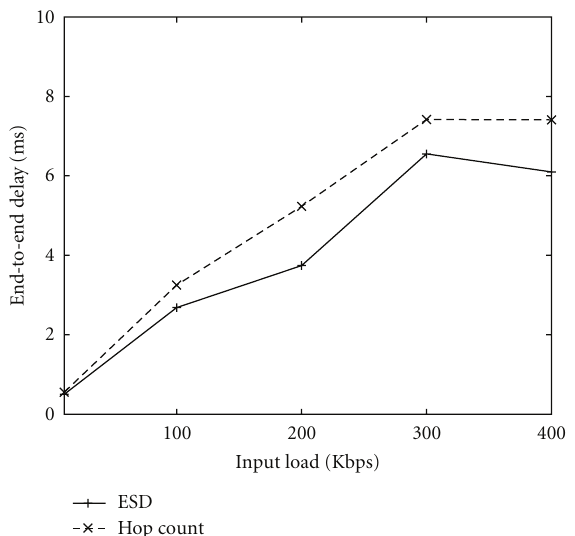
Figure 8: Delay comparison: delay sensitive versus best e ff ort